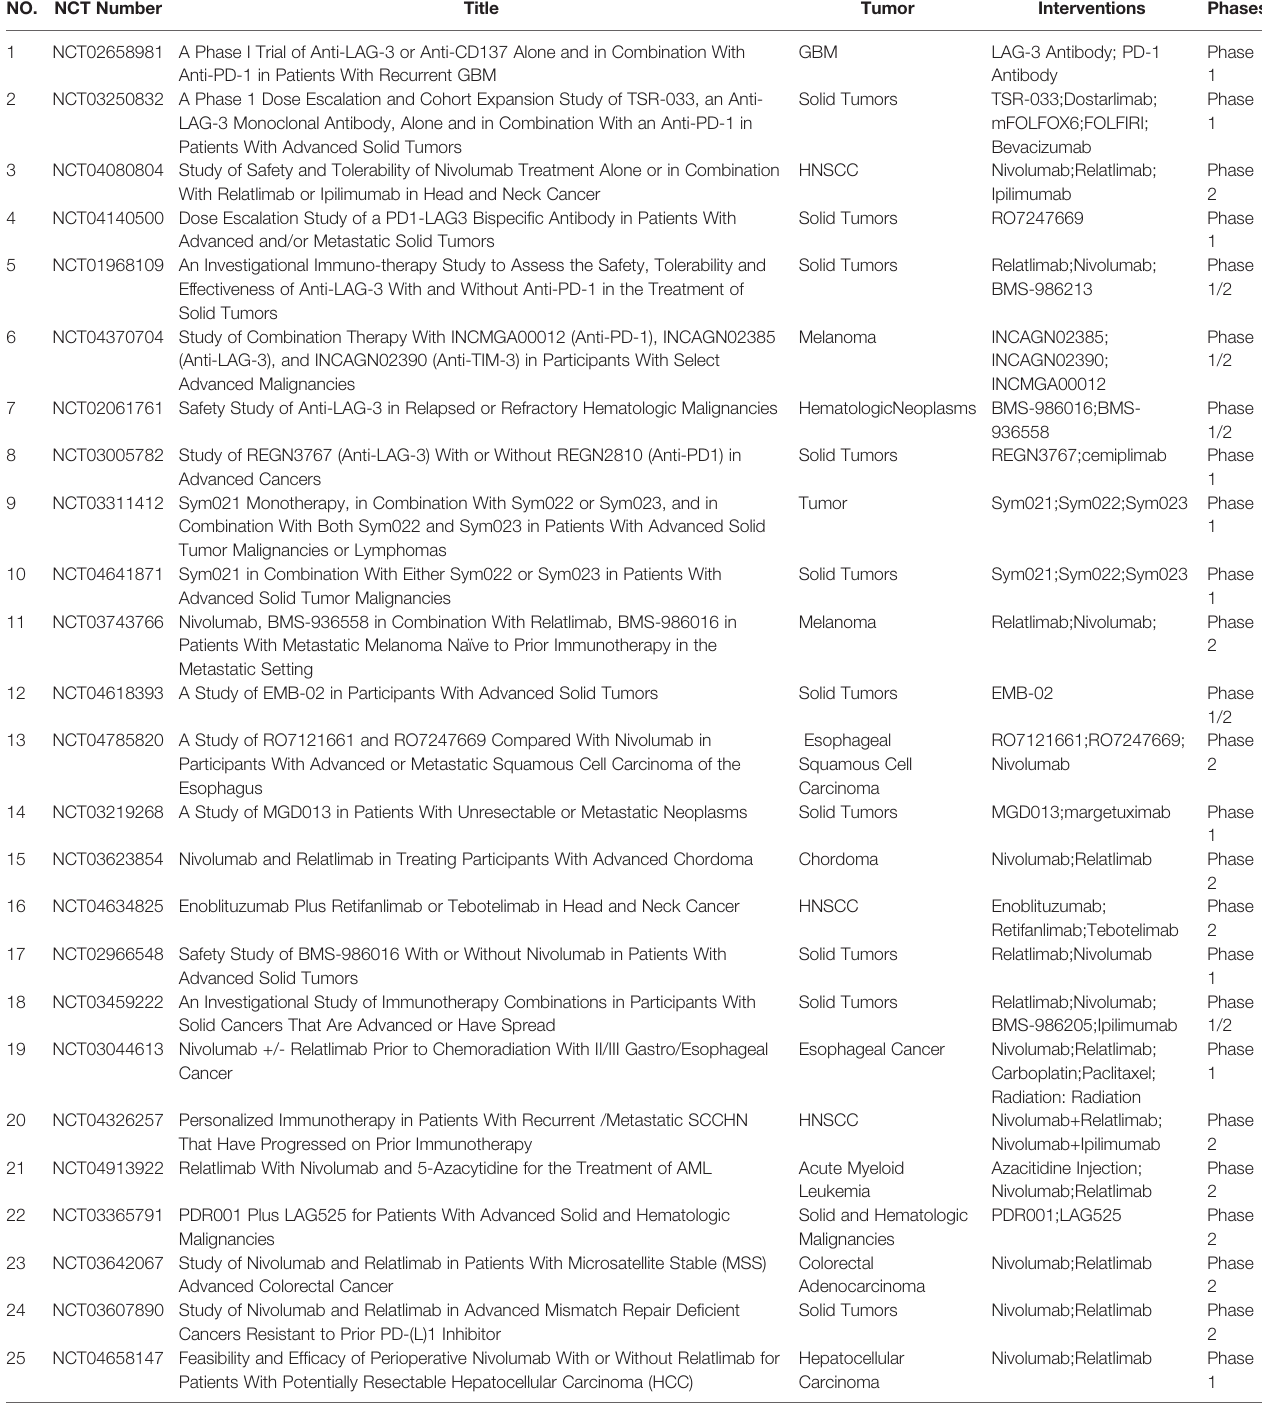
Abbreviations: Relatlimab, anti-LAG3 antibody; RO7247669, an anti PD-1 and LAG-3 bispeci fi c antibody; BMS-986016, anti-LAG-3; BMS-936558, anti-PD-1 Monoclonal Antibody (Nivolumab); EMB-02, a Bi-speci fi c Antibody Against PD-1 and LAG-3; RO7121661, a PD1-TIM3 Bispeci fi c Antibody; RO7247669, a PD1-LAG3 Bispeci fi c Antibody; MGD013,